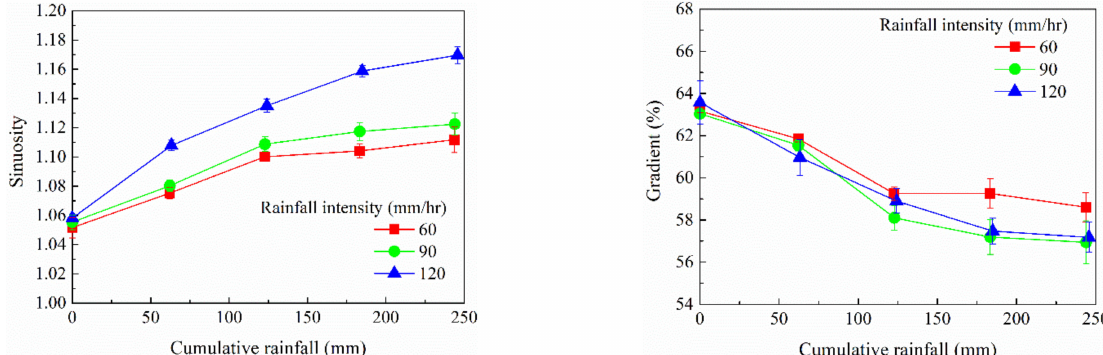
Figure 9. Changes of the stream sinuosity and gradient of the stream paths with cumulative